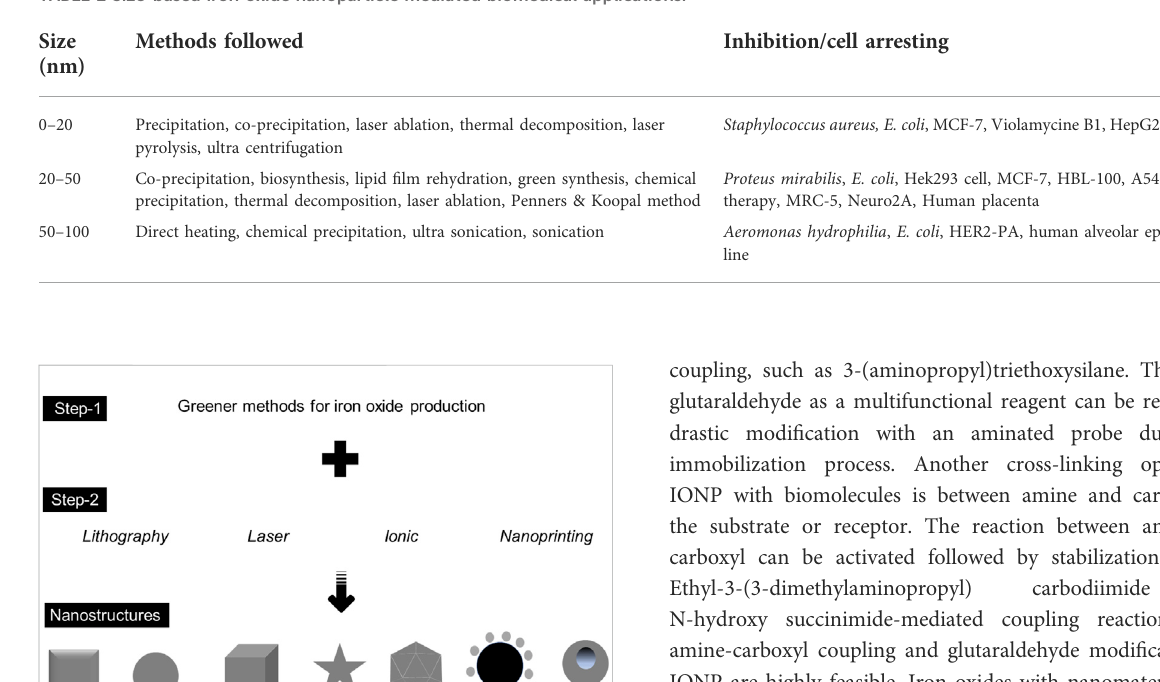
TABLE 2 Size-based iron oxide nanoparticle mediated biomedical applications.